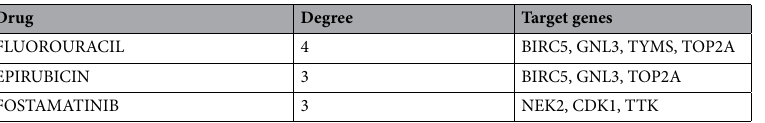
Table 4. High degree drugs in the drug-gene network. Of all the drugs, only those with degree 3 or higher have been reported.